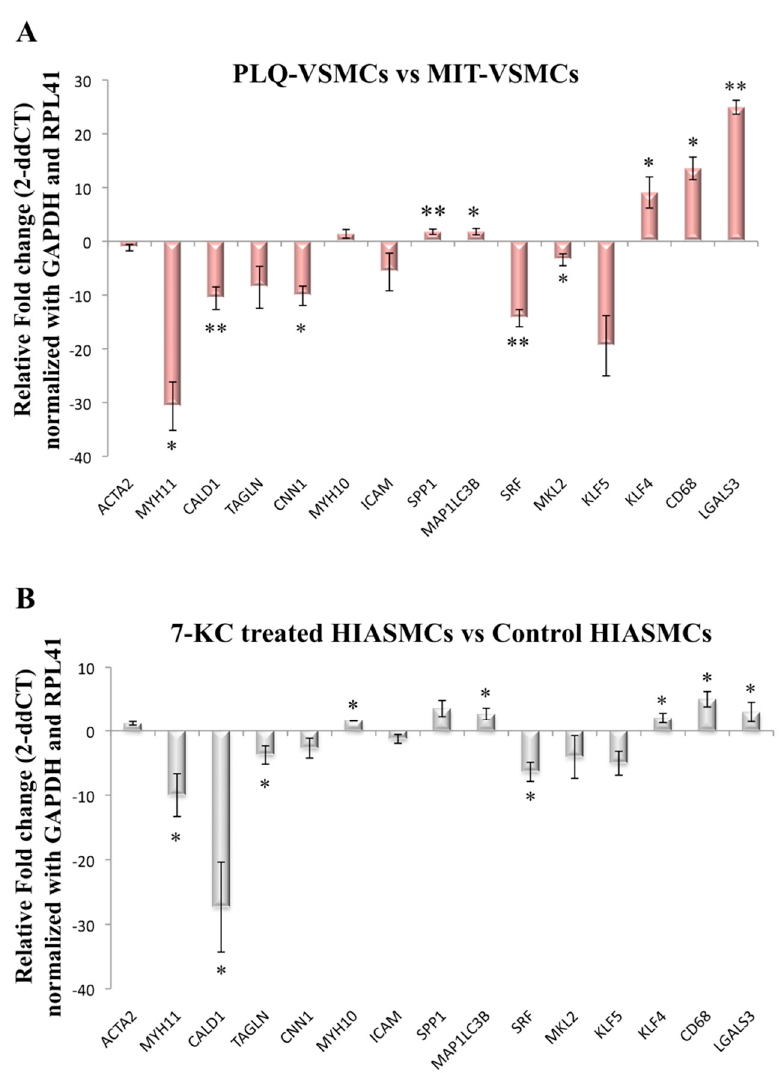
Figure 3. ( A ) Fold change differences of contractile and synthetic marker expression in 39 plaque VSMCs (PLQ-VSMCs) versus 39 macroscopically intact tissue area VSMCs (MIT-VSMCs) analyzed by quantitative PCR (error bars represent ± SEM n = 39). Data was normalized with GAPDH and RPL41. Wilcoxon matched-pairs signed rank test ( p < 0.05 * and p < 0.01 **); ( B ) Fold change differences of contractile and synthetic marker expression in 7-ketocholesterol treated (15 µM) HIASMCs versus not treated human iliac arterial SMCs (HIASMCs) analyzed by quantitative PCR (error bars represent ± SEM n = 3). Non-parametric Mann–Whitney U test was used ( p < 0.05 *).